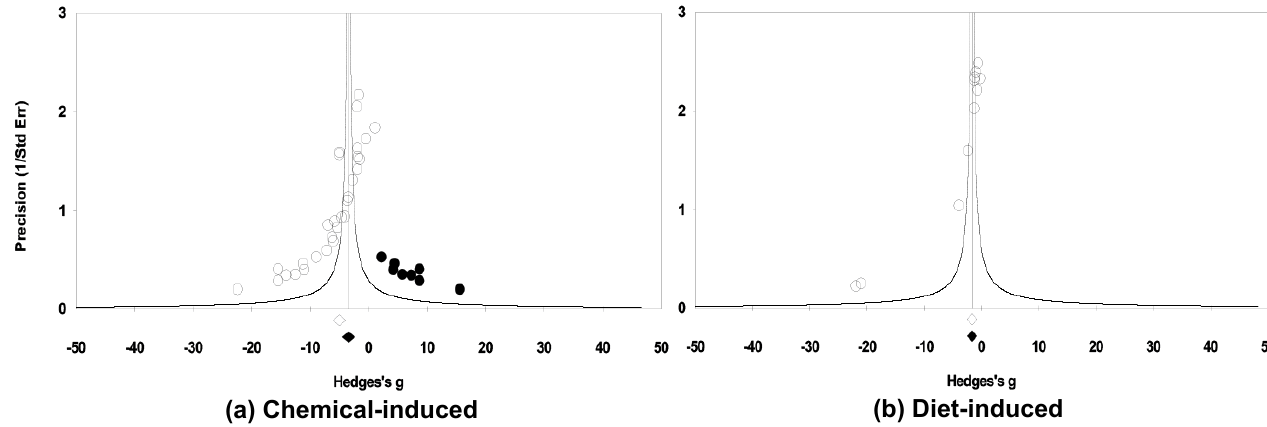
Figure 4. Funnel plots of standard error by Hedges’ g of blood glucose levels in chemical- ( a ) and diet-induced ( b ) DM rodents treated with or without MO. Open and closed diamonds indicate the imputed summary estimates before and after Duval and Tweedie’s Trim and Fill adjustment, respectively, in random-effects models. Closed circles represent imputed studies.